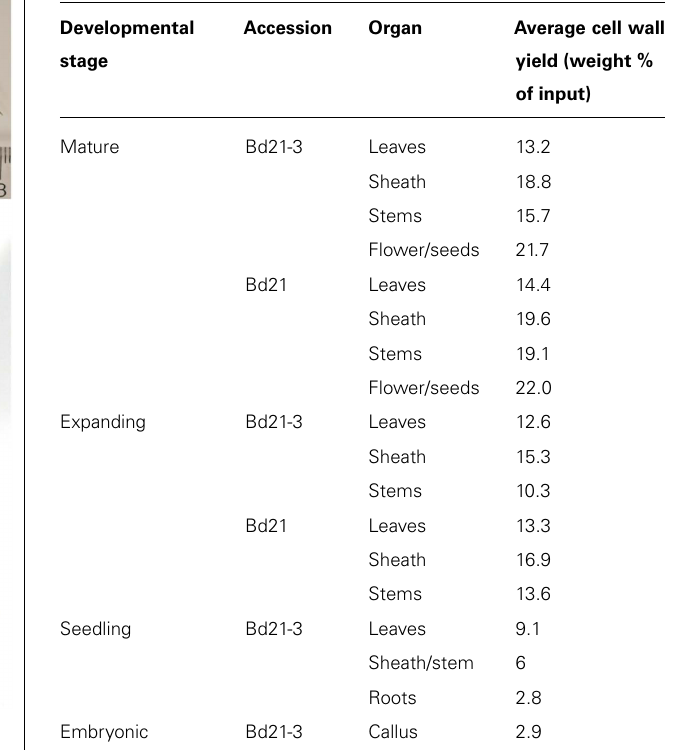
FIGURE 1 | Brachypodium distachyon developmental stages used for generation of tissue-specific cell walls for chemical analysis. (A) Embryonic callus. (B) Twelve-day-old seedling. (C) Expanding inflorescence/heading stage (BBCH stage range 57–61). (D) Seed fill/mature stage (BBCH stage range 69–75). All measurement scales are in centimeters. All samples shown are the Bd21-3 accession.